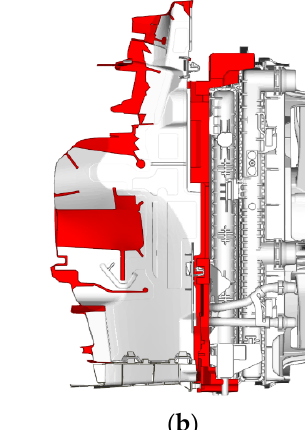
Figure 10. Optimized cooling module of PHEV . ( a ) Optimized structure front view; ( b ) optimized structure side view.